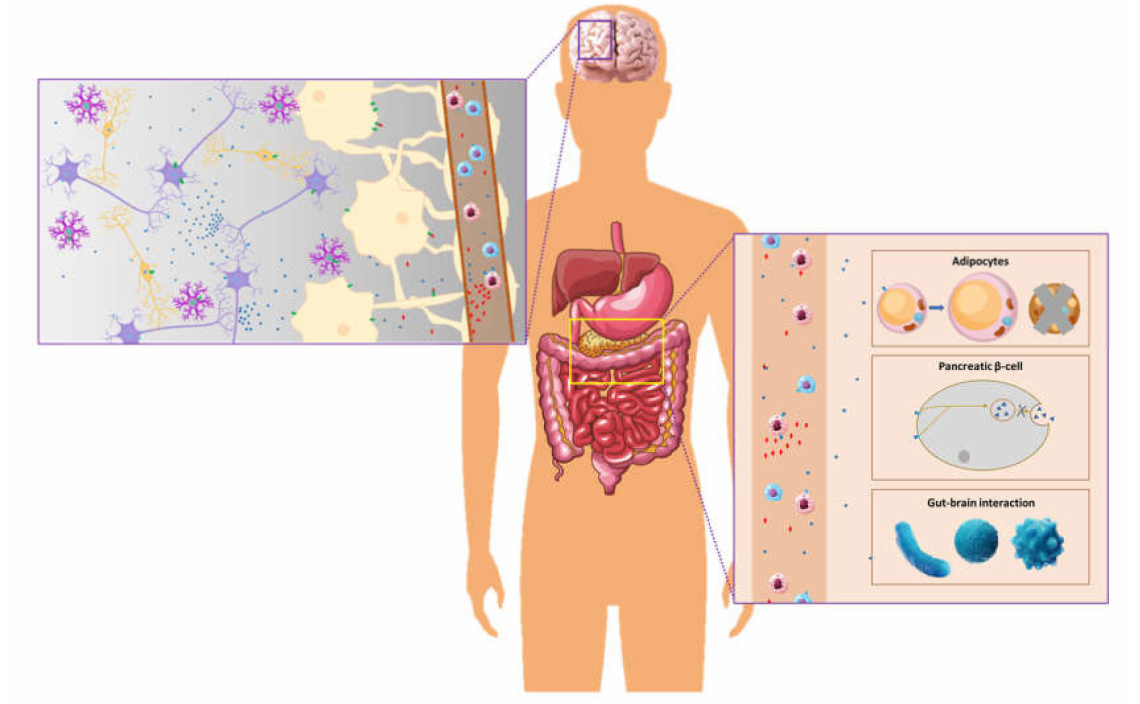
Figure 1. Widespread roles of neuropeptides in human physiology. Neuropeptides produced in the nervous system can modulate local neuron or glia function, through autocrine or paracrine effects. Through volume transmission, these neuropeptides find their way into the peripheral organs to modulate the function of peripheral organ systems (endocrine